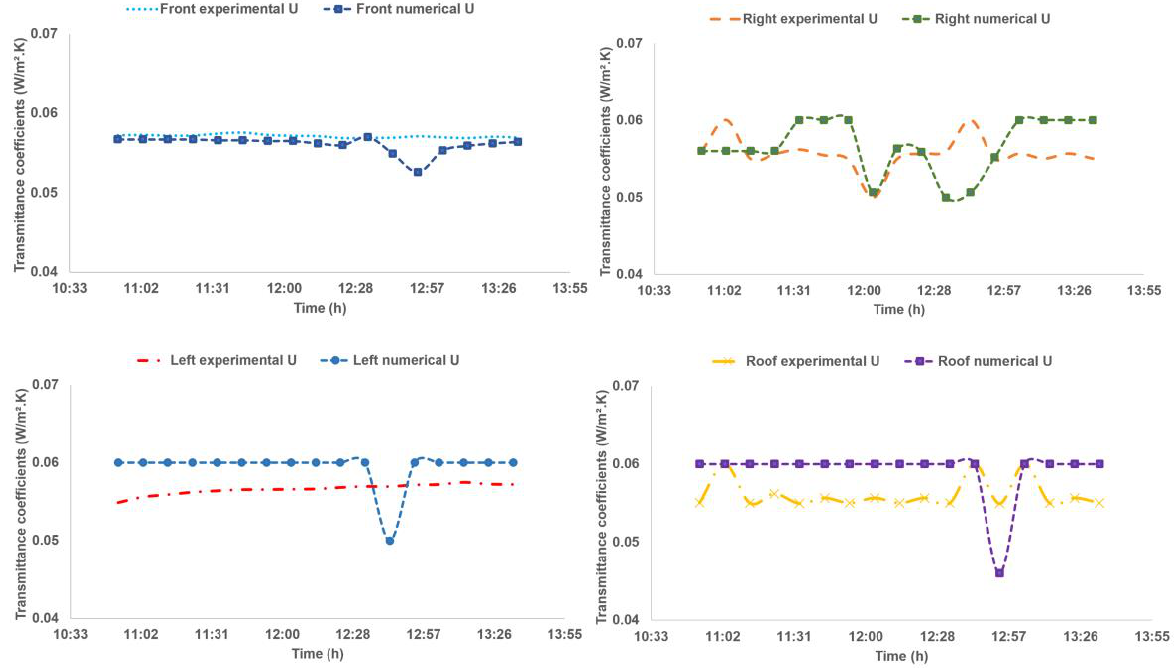
Figure 18. Numerical and experimental results.